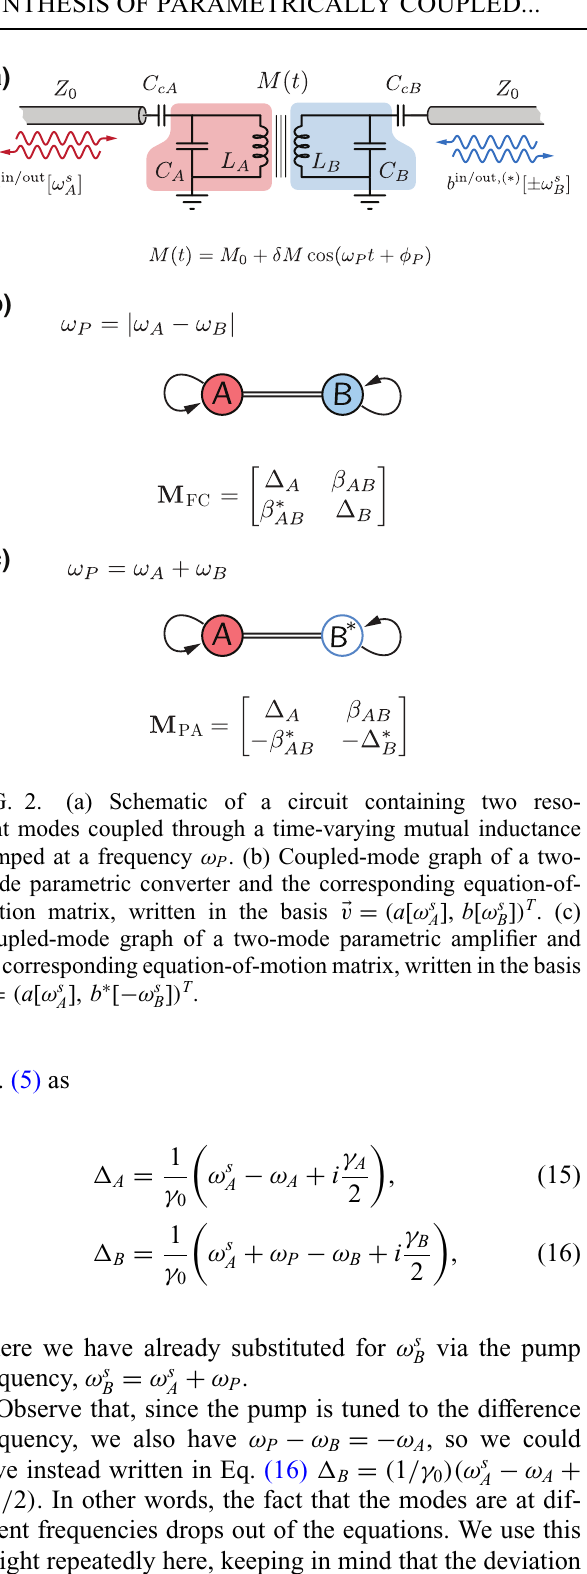
FIG. 3. S parameters of the two-mode frequency converter, calculated using Eq. (8). The frequency axis is referenced to the signal port: S AA is the reflection off of the input port at the / 2 π ; S indicated frequency, ω s BA is the conversion gain—output A + ω photon flux at port B at ω s P normalized to input flux at port A A at frequency ω s A